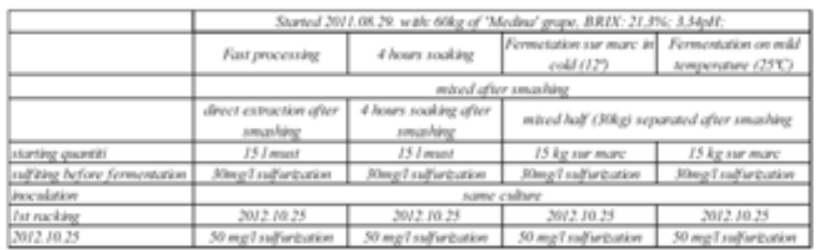
Table 3. Wine technology of ’Medina’ grape